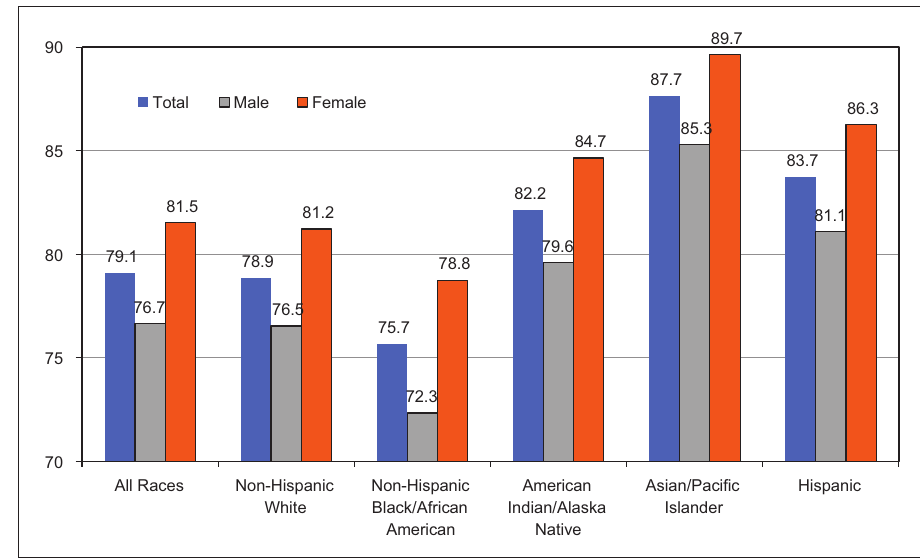
Fig ure 7. Life Expectancy at Birth (Years) by Race/Ethnicity and Sex, United States, 2015 Source: Data dervied from the National Vital Statistics